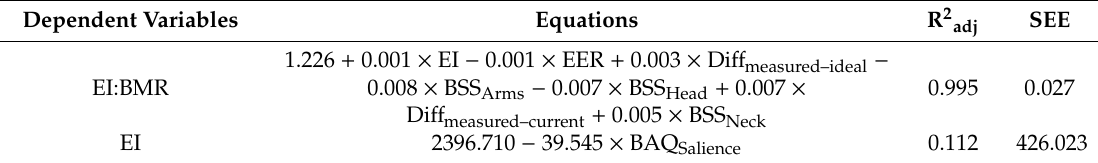
Table 6. Regression equations derived from stepwise multiple regression